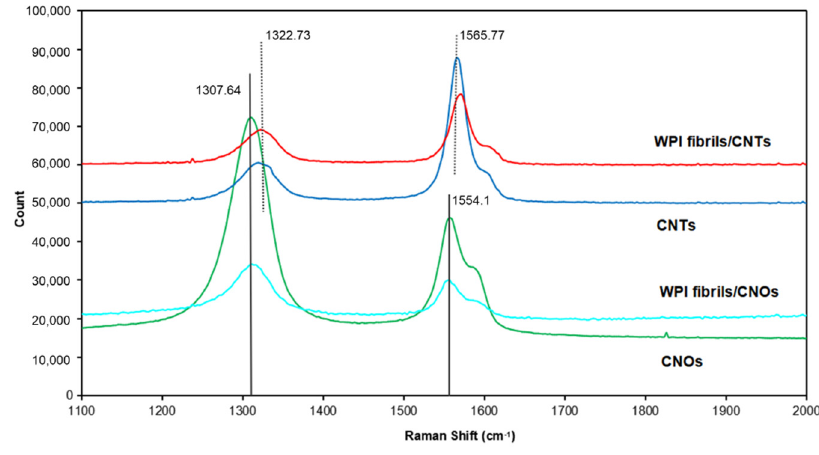
Figure 7. Raman spectra of WPI fibril–carbon nanocomposites and CNTs or CNOs.